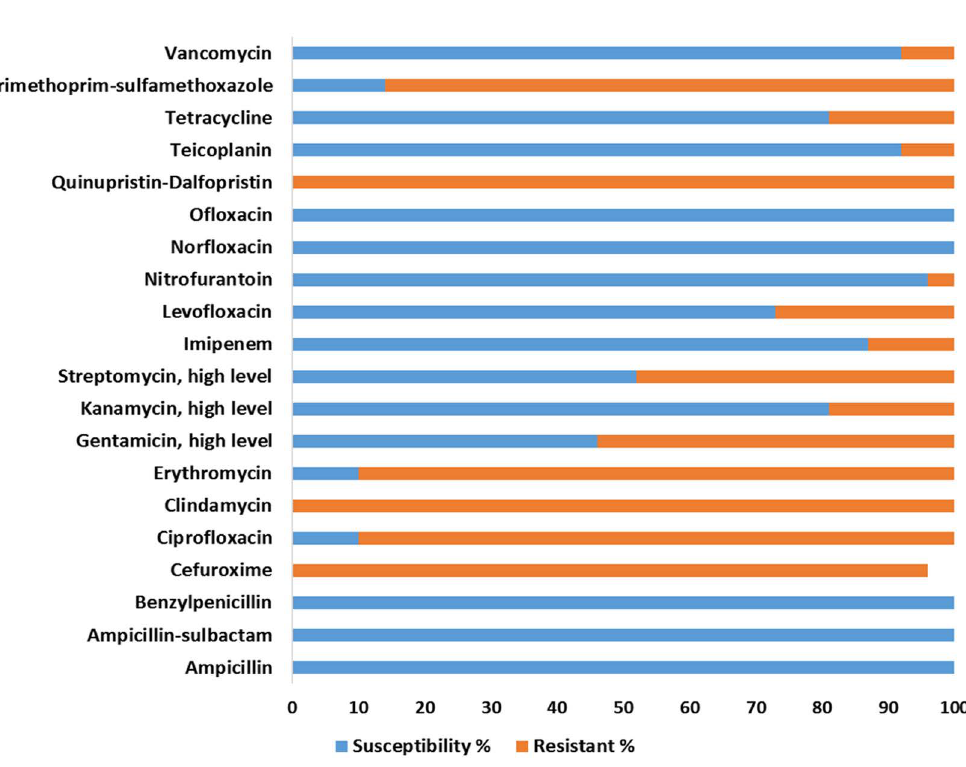
Fig. 1 . Susceptibility and resistance percentage (%) of E. faecalis against antimicrobial agents using Vitek 2 cards.